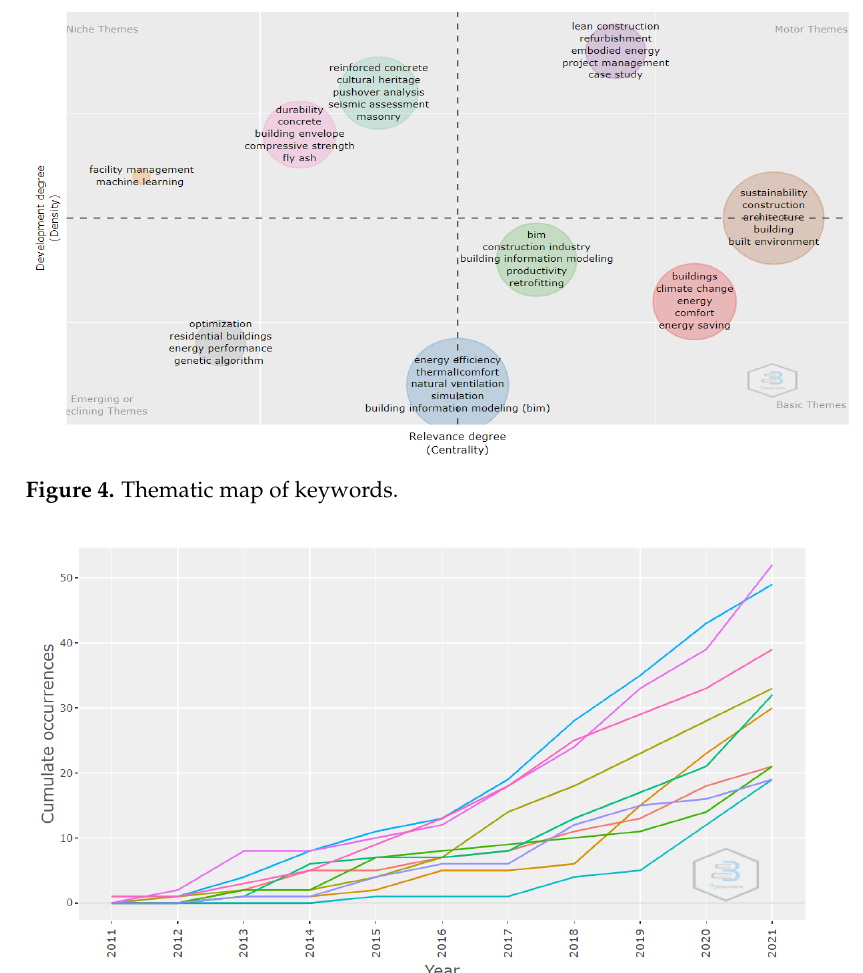
Figure 4. Thematic map of keywords.